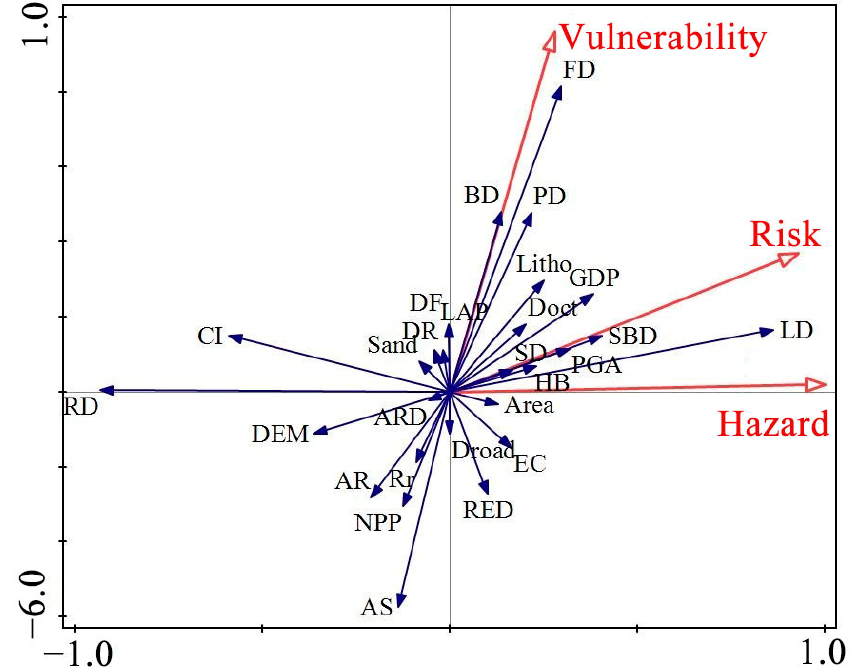
Figure 13. RDA ordination diagram of risk and environmental variables in the BRB.